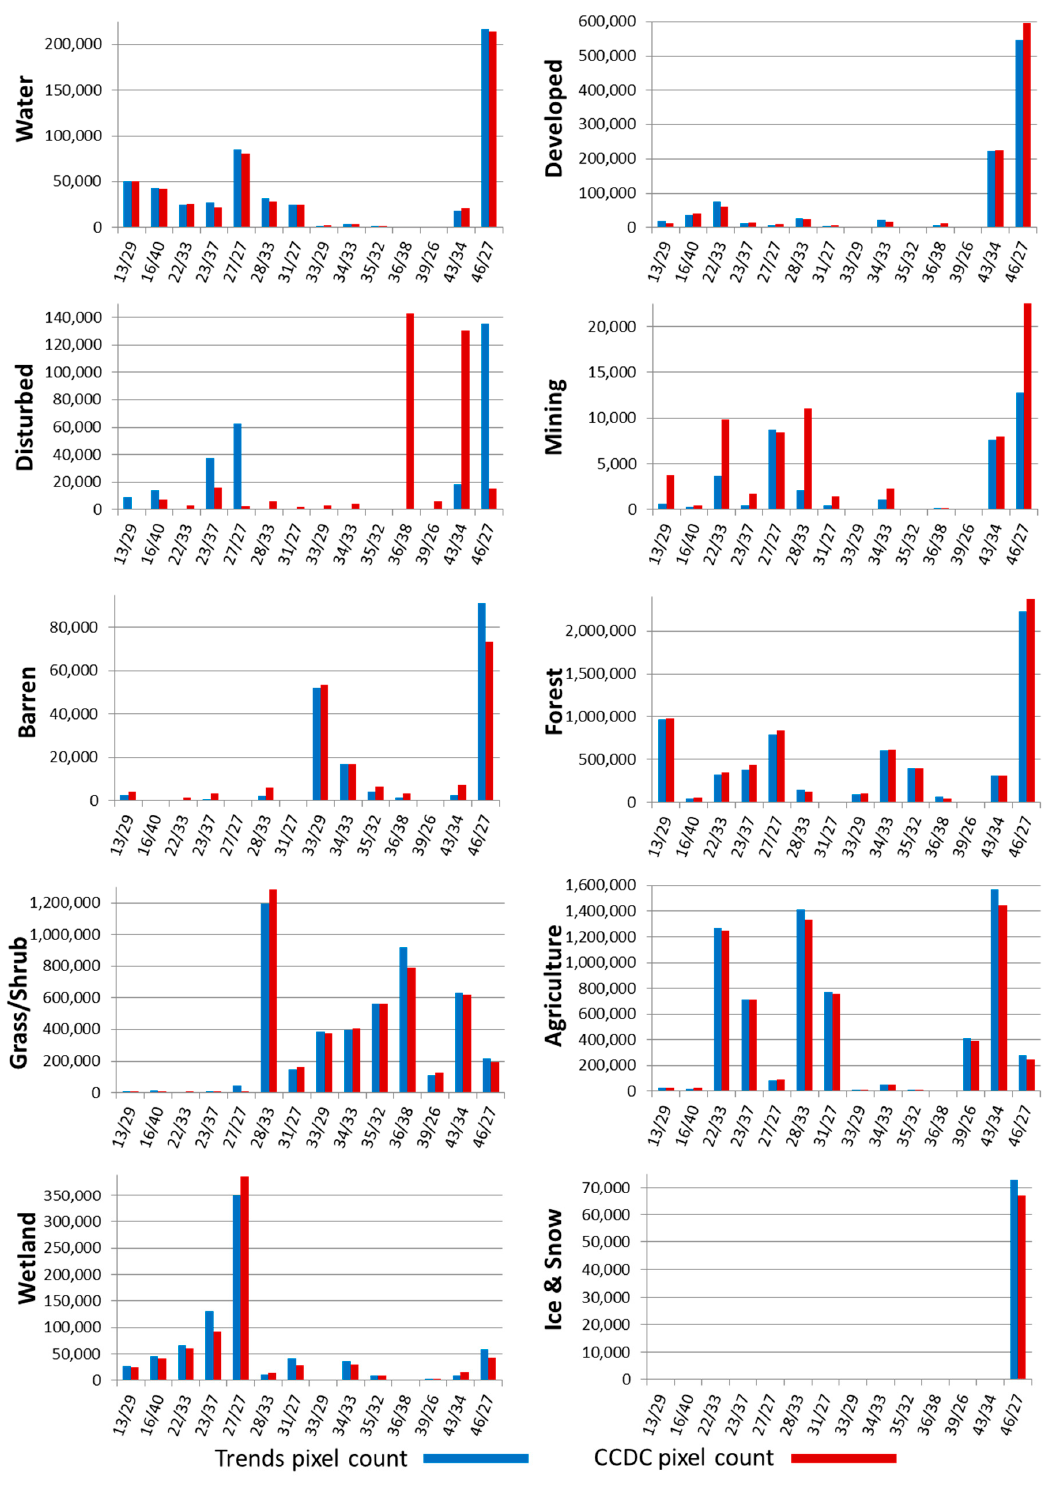
Figure 4. Comparison of class area mapped in each path/row by CCDC and LC Trends. Graph y -axes are scaled per class size to best display detail of comparison.